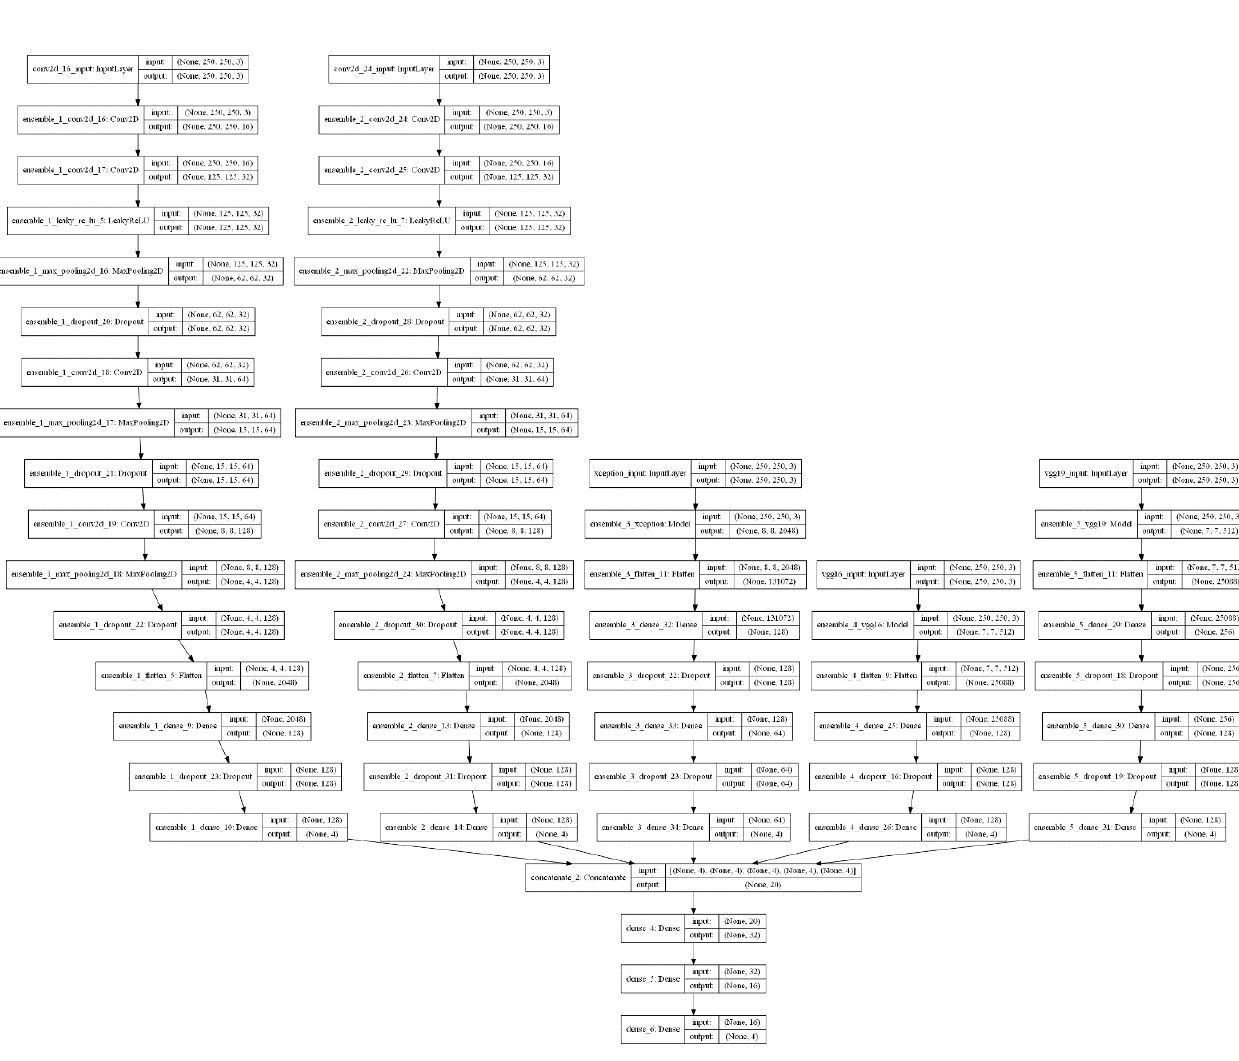
Figure 8. The Architecture of AiCNNs which is cascade of 5 classifiers (models (1), (2), (5), (7), (8)) from Table 2. Now, the AiCNNs model has been depicted in figure 8 and has been cascaded and concatenated from models (1), (2), (5), (7) and (8) of Table 2. Here, all the 5 models discussed above had been loaded using the load_model() function of keras.models package. The inputs that had been fed to all models remained the same except that of the model (2) whose inputs had been scaled by a factor of 255.0 to normalize the pixel values around 1. The outputs of these models had then been concatenated together using concatenate() function of keras.layers.merge package. This concatenated layer of outputs had been passed through 2 hidden layers, first having 32 hidden layer neurons (dense_1), and the second having 16 hidden layer neurons (dense_2). Both these hidden layers used ReLU (eq. (3)) activation layer. Finally, the output layer has 4 output layer neurons corresponding to the 4 classes discussed